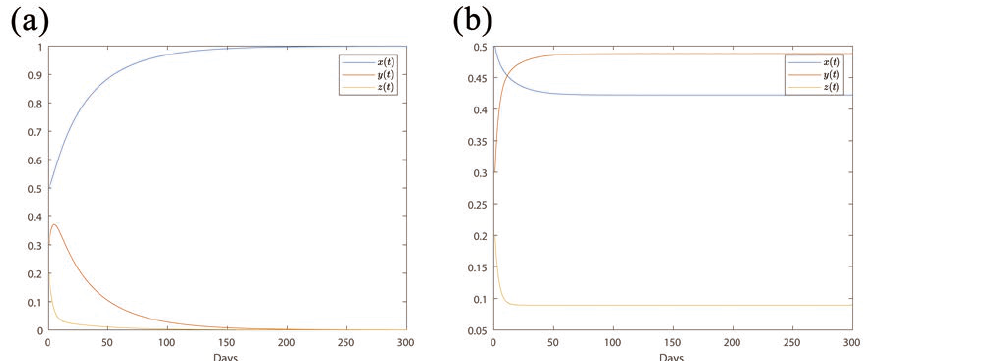
Figure 2. Numerical simulation of this model. ( a ) The dynamic trend of the proportion of Low-, Medium-, and High-risk areas at R 0 = 0.47. The Medium- and High-risk areas gradually diminish. ( b ) The dynamic trend of the proportion of Low-, Medium-, and High-risk areas at R 0 = 2.37. The proportion of the Medium-risk areas approaches 0.48, and the proportion of the High-risk areas approaches